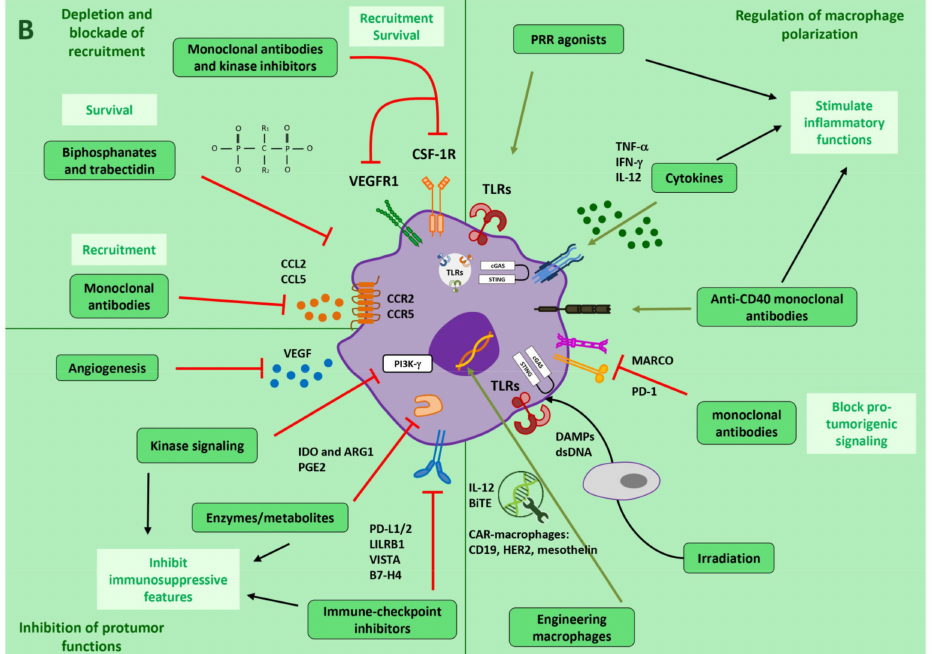
Figure 2. ( A ) Describes the main known antitumor functions of macrophages in particular tumor cell killing and phagocytosis as well as recruitment and activation of immune cells in the TME. ( B ) Presents the current therapeutic strategies that target TAMs to induce anticancer responses. On the top left side are different approaches to kill macrophages or inhibit their recruitment in tumors. On the bottom left side are approaches to inhibit TAM protumor functions. On the right side are strategies to re-educate TAMs into antitumor